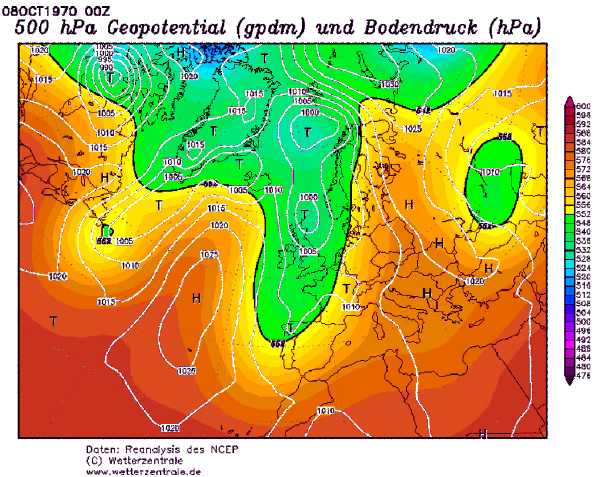
Fig. 5. Isohyets map of 7–8 October 1970 in the Genoa area (from Cati,